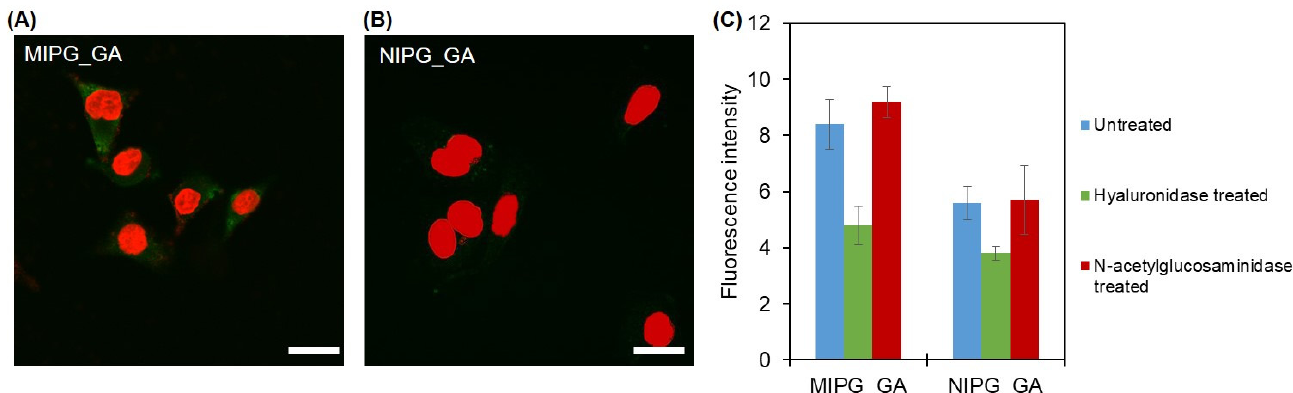
Figure 4. Confocal microscope images of fixed Hela cells incubated MIPG_GA ( A ) and NIPG_GA ( B ), that exhibit green fluorescence under proper filter sets of confocal microscopy. Nuclei stained with PI (red). Scale bar: 50 μ m. ( C ) Summarized histogram results showing the binding performance of polymers towards untreated, hyaluronidase treated, and N-acetylglucosaminidase treated Hela cells. Data are means of three independent experiments. The error bars represent standard deviations.